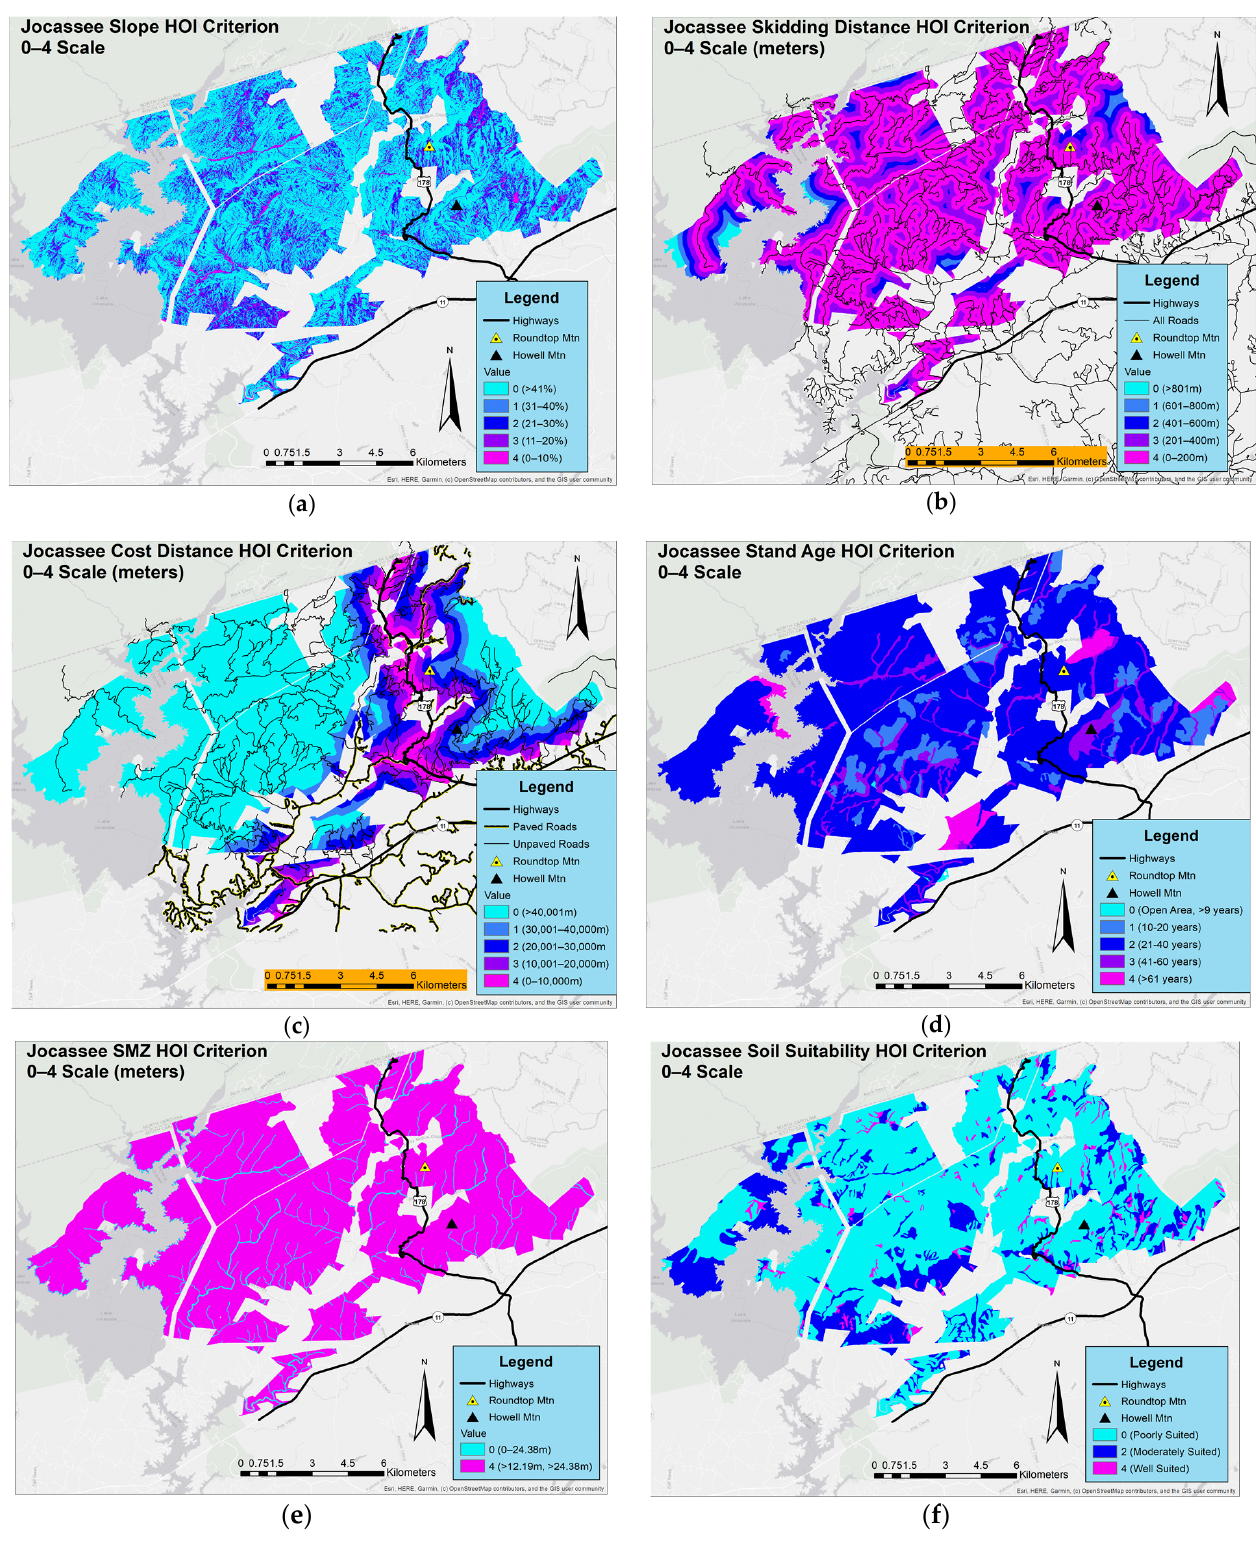
Figure 3. HOI criteria outputs on a 0–4 scale for Jocassee: ( a ) Slope HOI criterion; ( b ) Skidding Distance HOI criterion; ( c ) Cost Distance HOI criterion ( d ) Stand Age HOI criterion ( e ) SMZ HOI criterion ( f ) Soil Suitability HOI criterion.